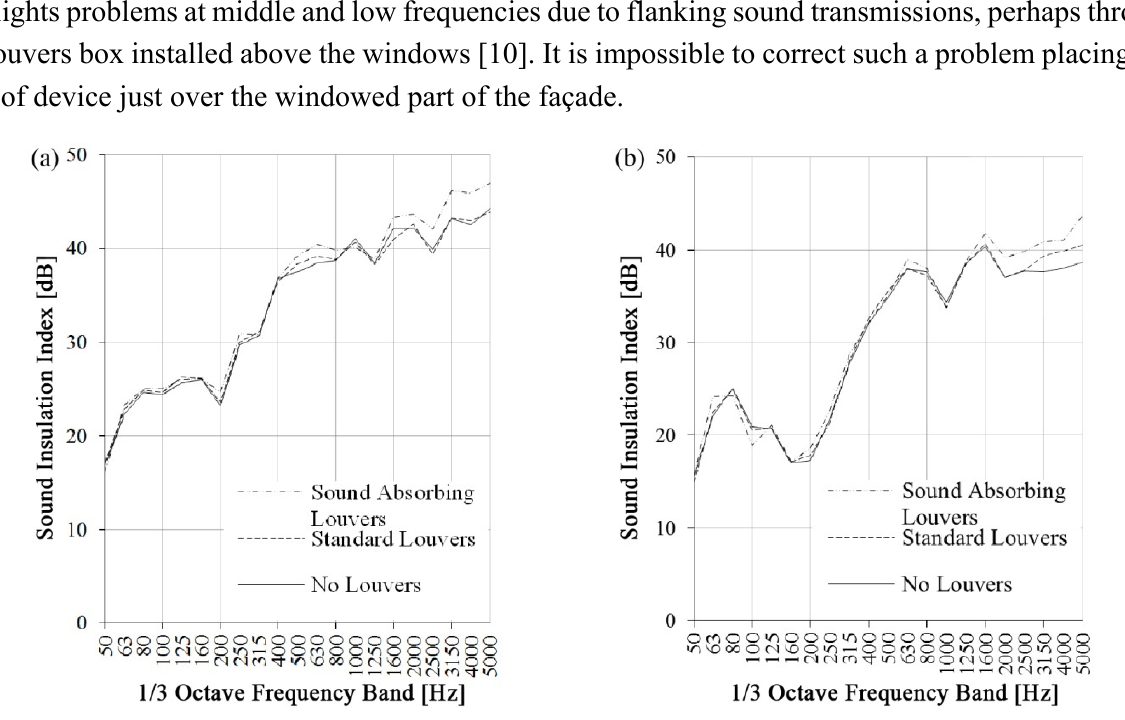
Figure 15. Façade sound insulation curves measured without louvers (solid lines), with standard louvers (dashed lines) and with sound absorbing louvers (dash-dotted lines). Louvers tilt angle is 0°. ( a ) Ground floor façade portion; ( b ) third floor façade